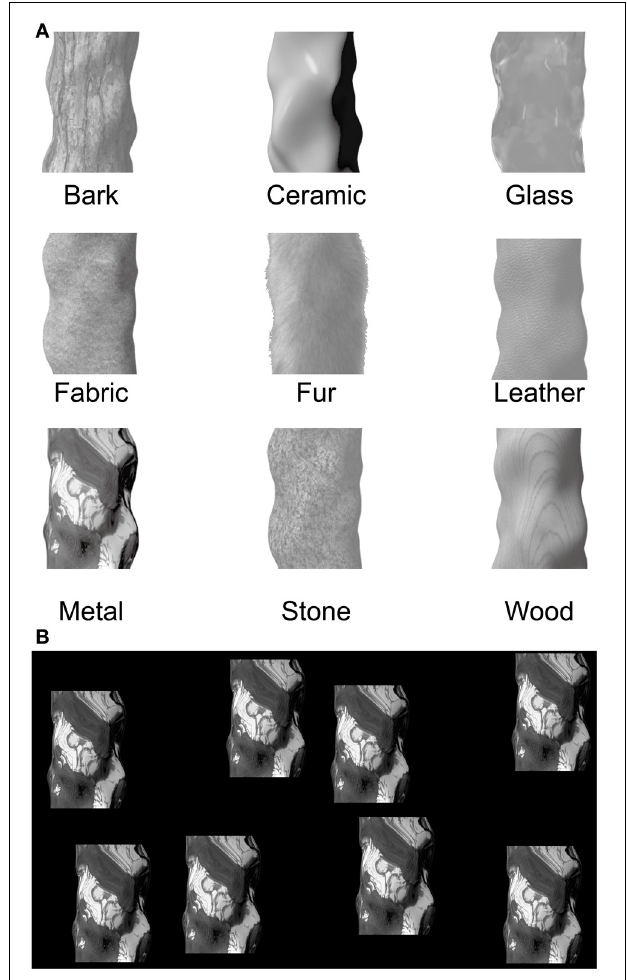
FIGURE 1 | Visual stimuli used in this study. (A) The images of nine surface qualities. Each image corresponds to a material category we encounter in our daily life. (B) The vection stimulus consisted of eight objects moving